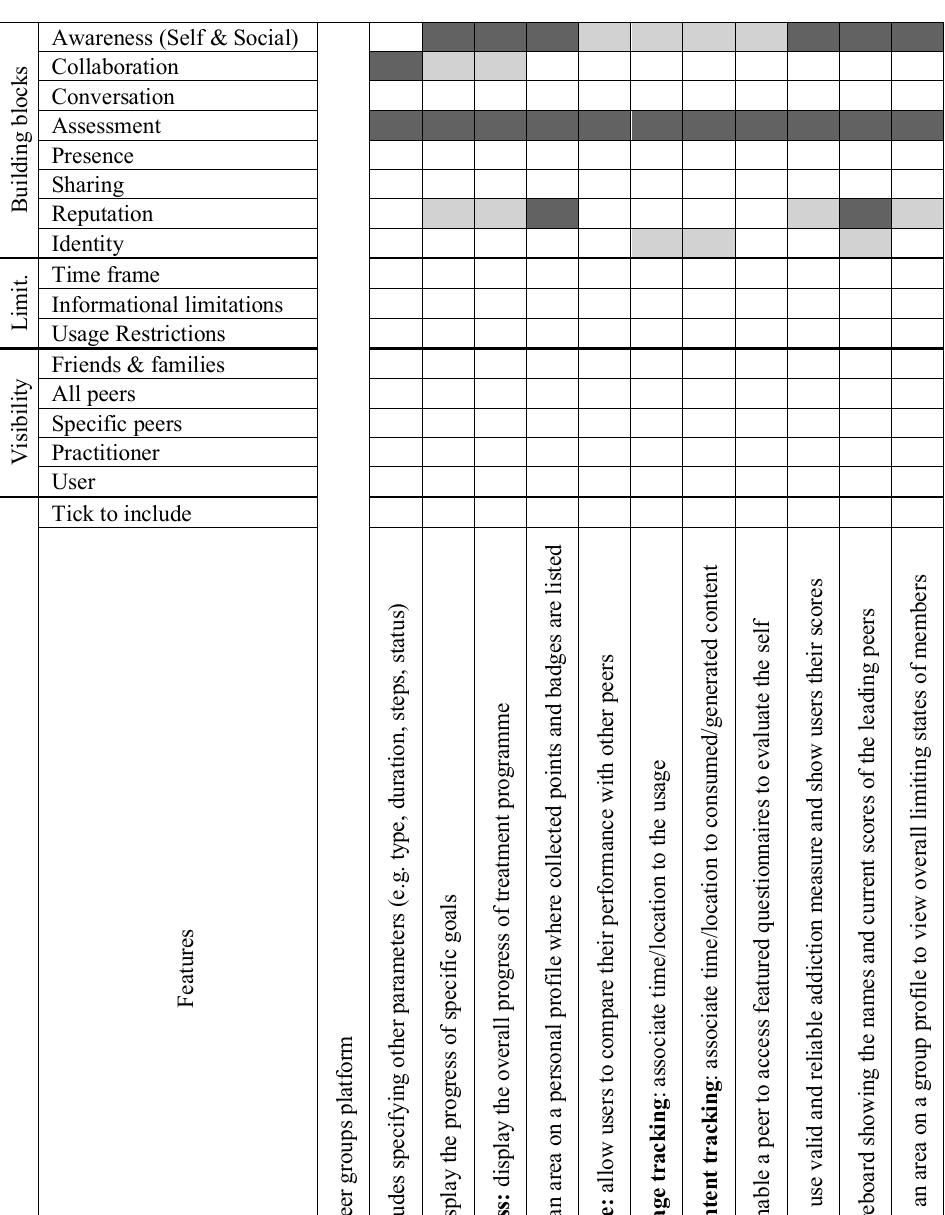
Table 4. Interactive features repository.